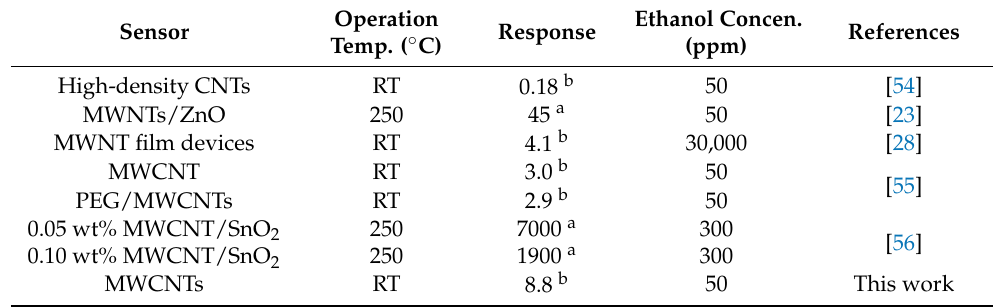
Table 2. The ethanol sensor response and operating temperature based on published CNT work.